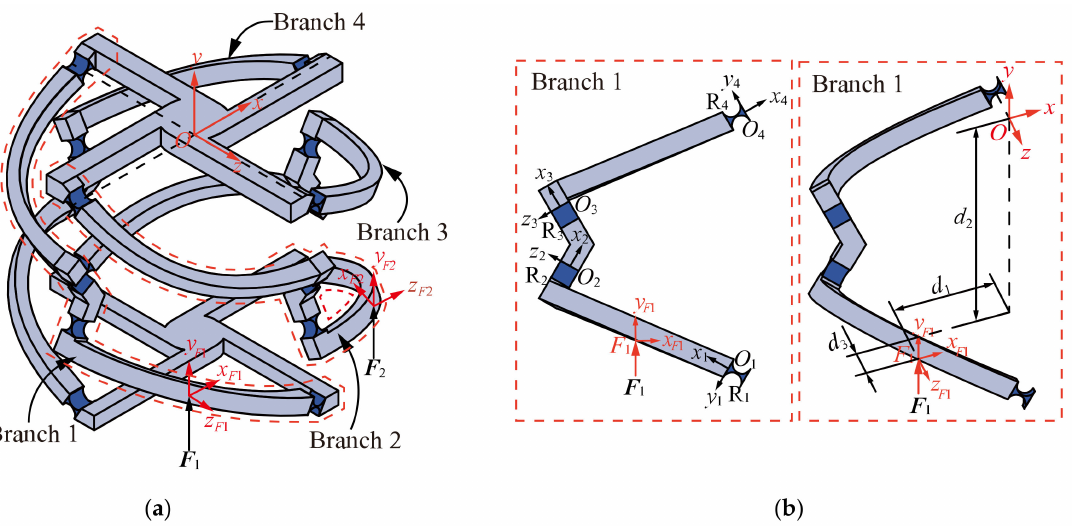
Figure 9. ( a ) Complete overview of the 4-4R compliant parallel pointing mechanism to analyze; ( b ) coordinate frame setting and loading position of force F 1